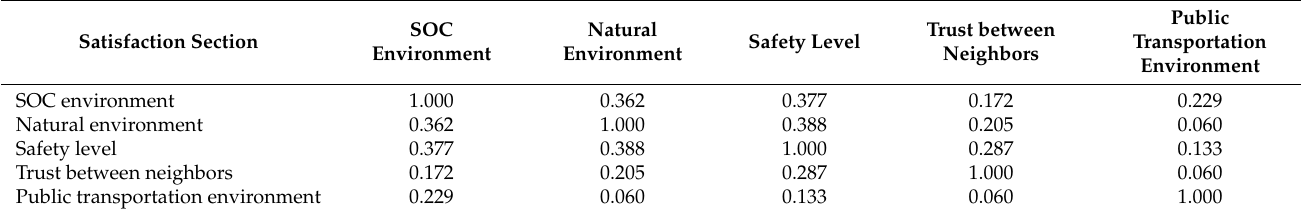
Table 6. Correlations between the sectors of neighborhood environment: Young adult group (19–34). Satisfaction